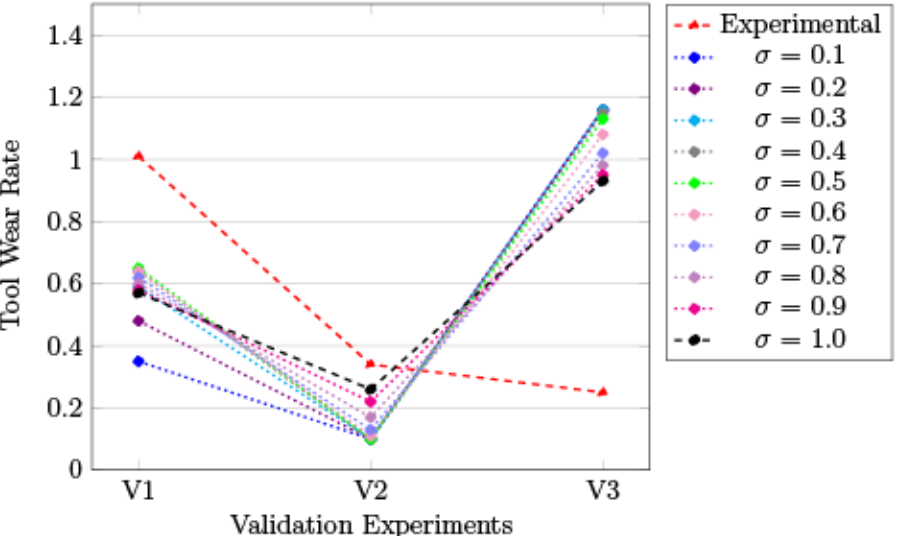
Figure 10. GRNN model testing for TWR with different smoothing factors.